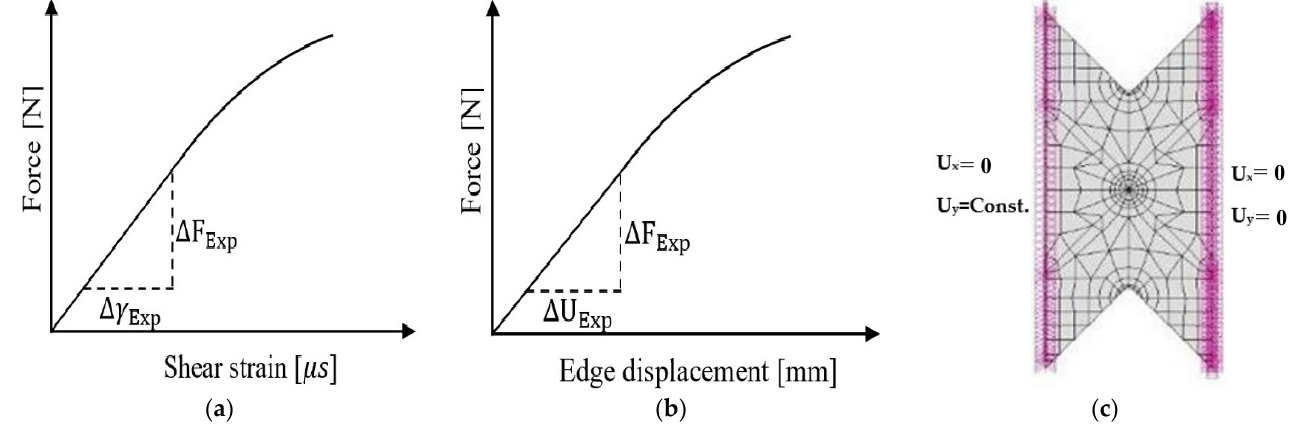
Figure 22. Experimental curves used for the FEA procedure; ( a ) F vs. γ ; ( b ) F vs. displacement; ( c ) FE model and boundary conditions.